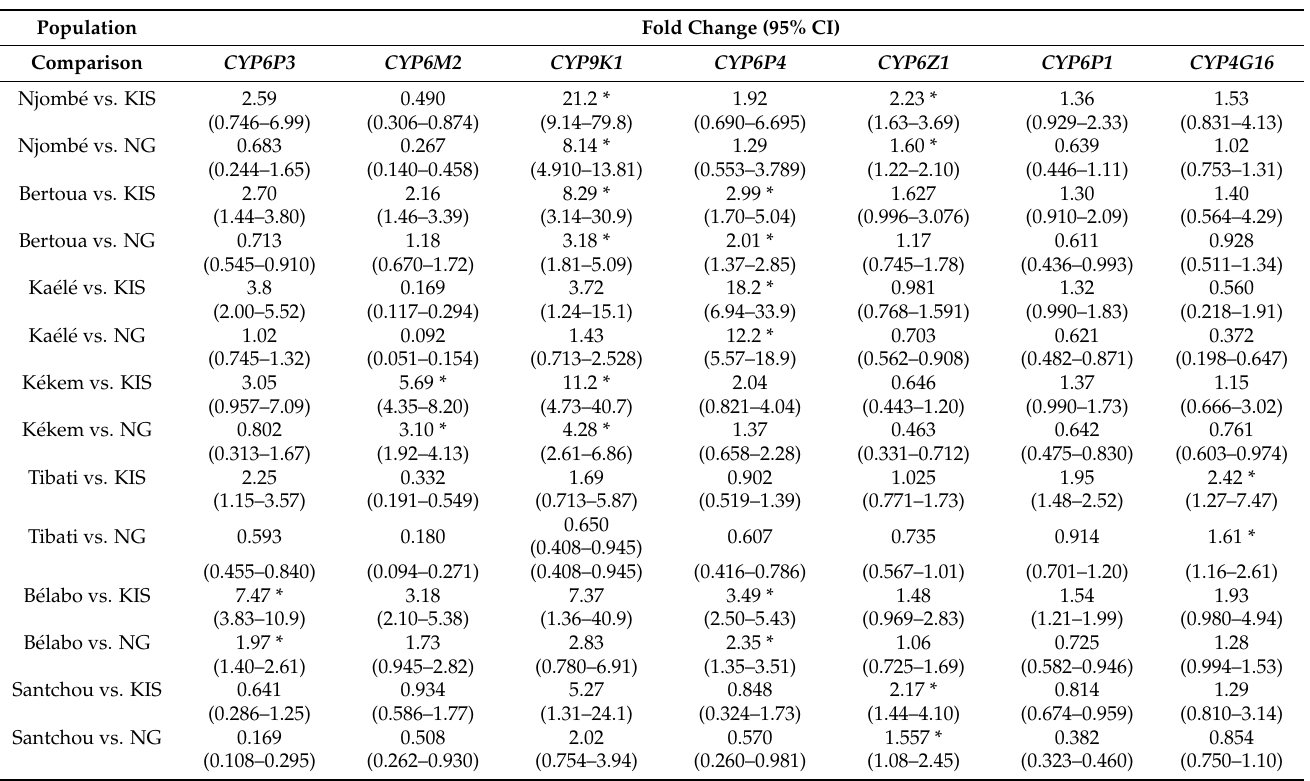
Table 2. Gene expression analysis in the seven resistant mosquito populations compared to the susceptible strains. Bold letters indicate statistically significant upregulation, and asterisks (*) indicate consistent upregulation compared to both susceptible